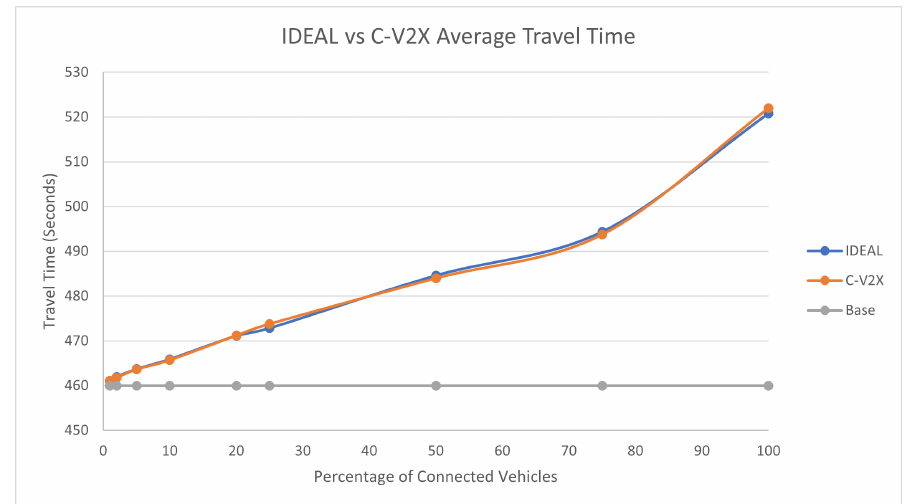
Figure 14. Average network-wide Travel Time of Energy-Efficient dynamic routing application using IDEAL and C-V2X communication on LA road network with traffic demand of scale factor 0.25.